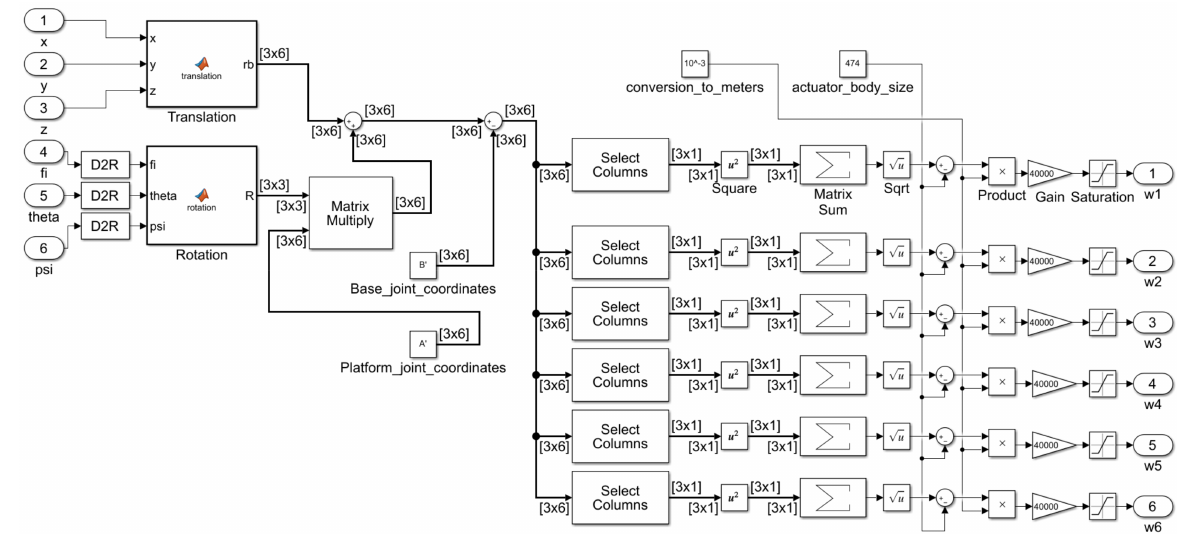
Figure 13. The inverse kinematics algorithm coded in the Matlab/Simulink environment.